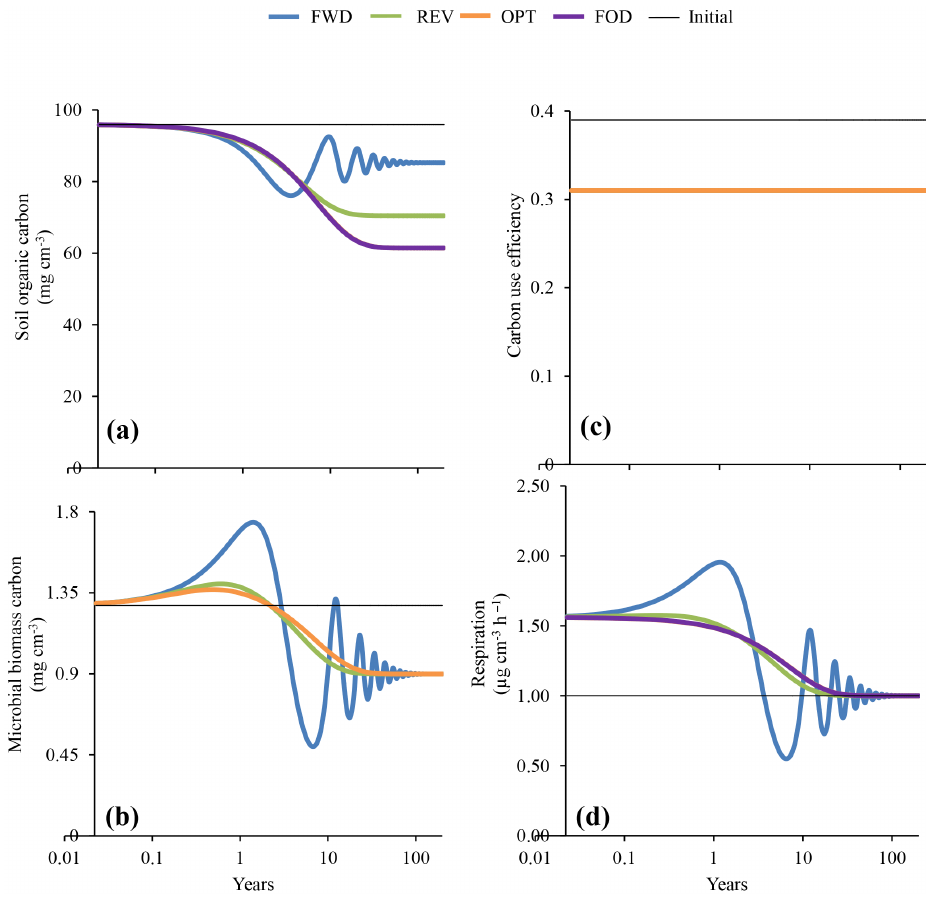
Figure 2. Responses of (a) soil organic carbon, (b) microbial biomass carbon, (c) CUE, and (d) respiration to a 5 ◦ C warming in the base models (FWD vs. REV and OPT, Fig. 1a). The black line represents initial values, which are model equilibria at 15 ◦ C. We chose logarithmic axes for time to better highlight the differences in short-term responses. We note that the differences in simulated soil organic carbon and respiration for the OPT and the FOD are almost equal and therefore not discernible. Also, values of CUE at warmed temperature are identical in all models, and therefore, the orange line is superimposed on blue and green lines. In the OPT model, simulations are carried out at zero enzyme production cost, i.e. µ 2 = Kp · c =